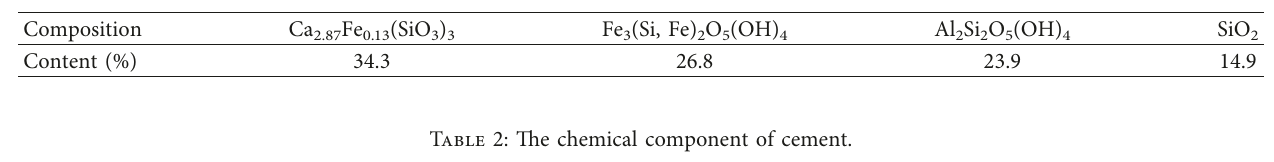
Table 1: The main mineral content in Xinyang coal gangue of Fenxi Coal Mine group (%).